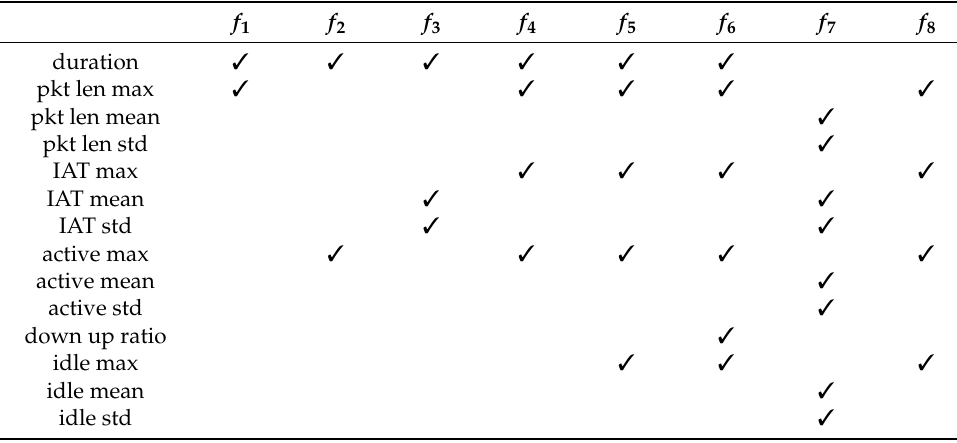
Table 3. Bidirectional (whole) flow-based